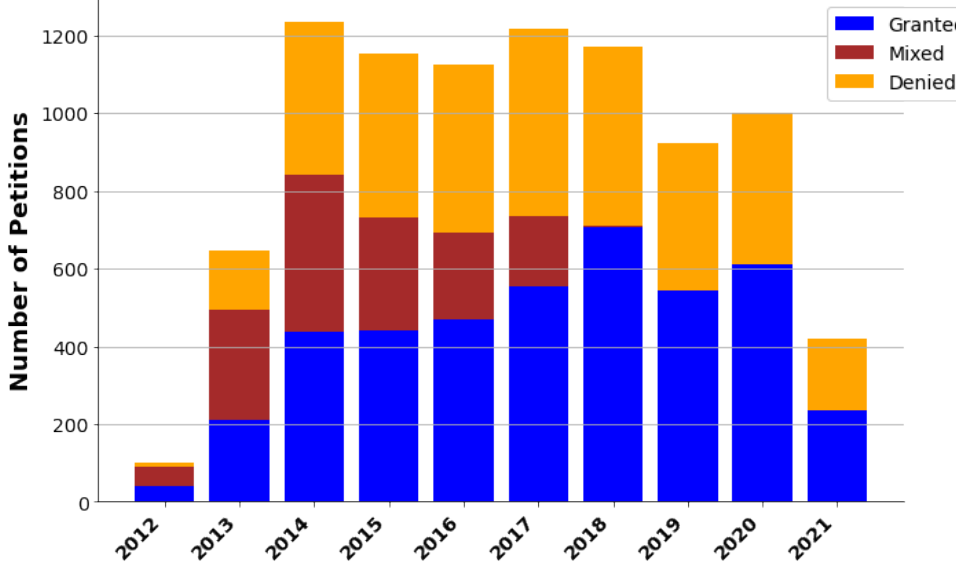
Figure 3. Institution decisions by petition filing year in the data set (combining IPR, PGR, and CBM as we do for the analysis in this paper) from the AIA’s effective date in September 2012 through the data set cutoff of 31 December 2021, showing grant (blue, bottom), denial (orange, top), and mixed (brown, middle) outcomes. Notably, in 2018, the U.S. Supreme Court’s SAS decision eliminating the possibility of a mixed